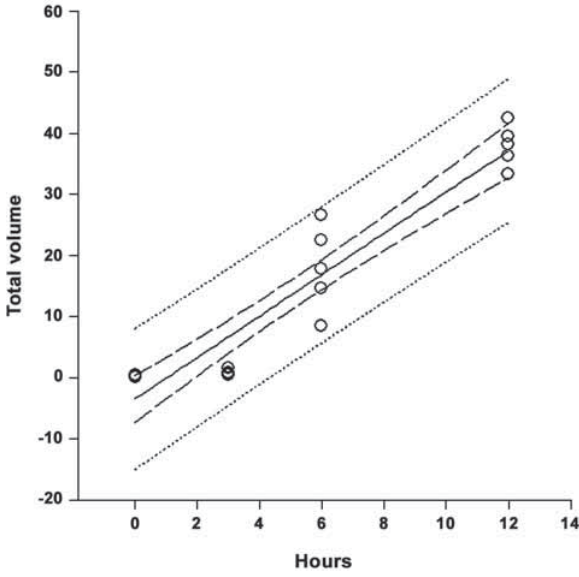
FIGURE 2- Linear regression analysis of the total volume of autolyzed acini from 0 to 12 h